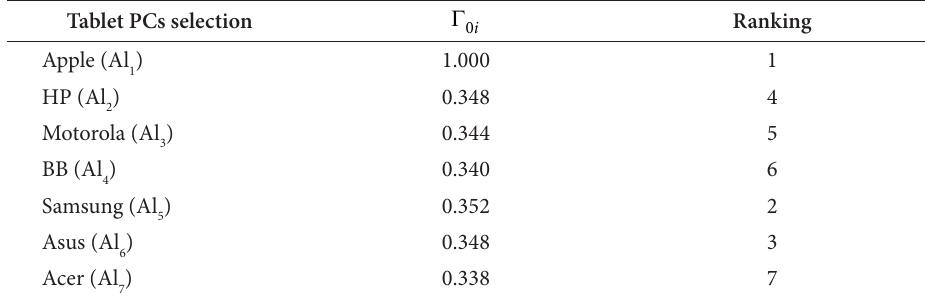
Table 4. The final evaluation and ranking of tablet PCs (Summary of the GRA 0 i Γ )